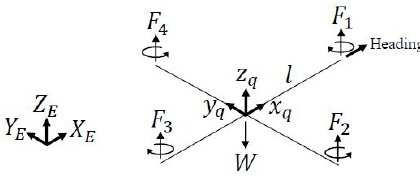
Figure 6. Quadrotor configuration.